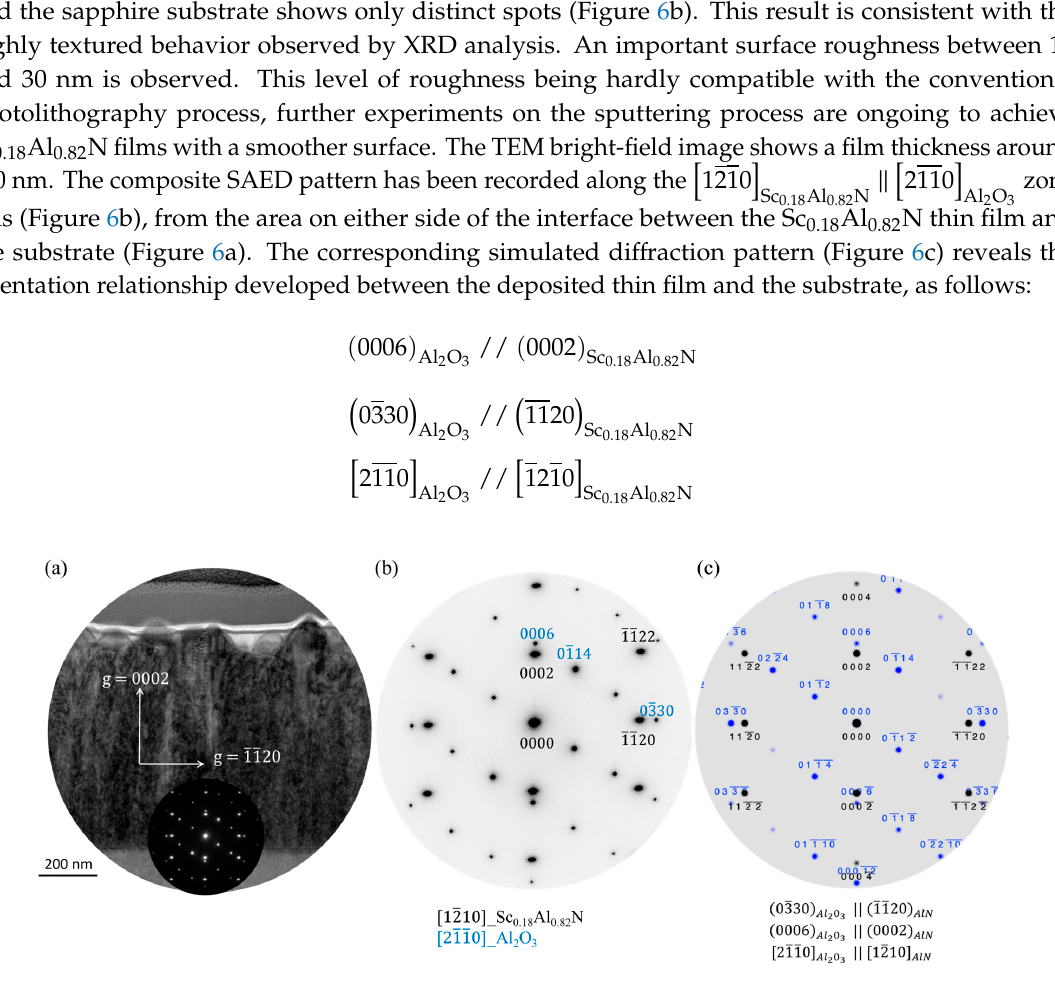
Figure 6. TEM bright-field image of a Sc 0.18 Al 0.82 N thin film deposited on a sapphire substrate ( a ). Composite SAED pattern recorded along the (cid:4670)12(cid:3365)1(cid:3365)0(cid:4671) 𝑆𝑐 the area on either side of the interface between the Sc 0.18 Al 0.82 N thin film and the Sapphire ( b ). Corresponding simulated diffraction pattern revealing the orientation relationship developed between the deposited thin film and the substrate ( c ).